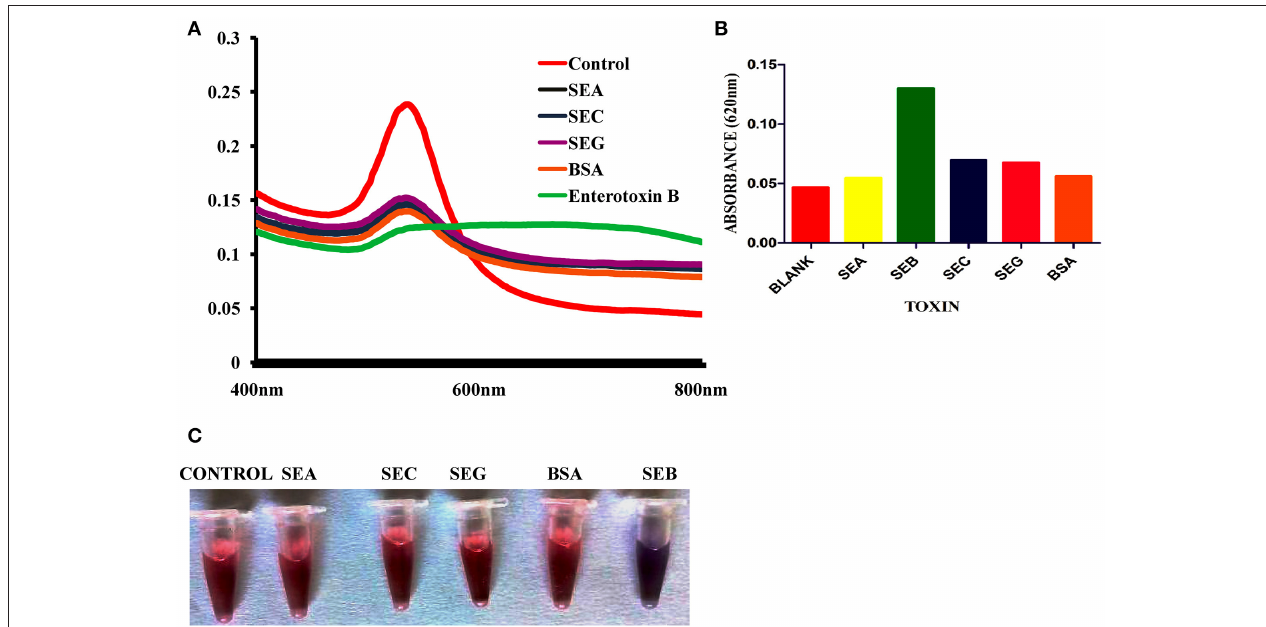
FIGURE 6 | Selectivity of Gold nano particle based colorimetric detection assay. (A) Absorption spectra of AuNPs/aptamer mixed solutions in the presence of other related toxin. (B) Absorption value at 620nm of AuNPs/aptamer mixed solutions in the presence of other related toxin. (C) Visual observation of AuNPs/aptamer mixed solutions in presence of other related